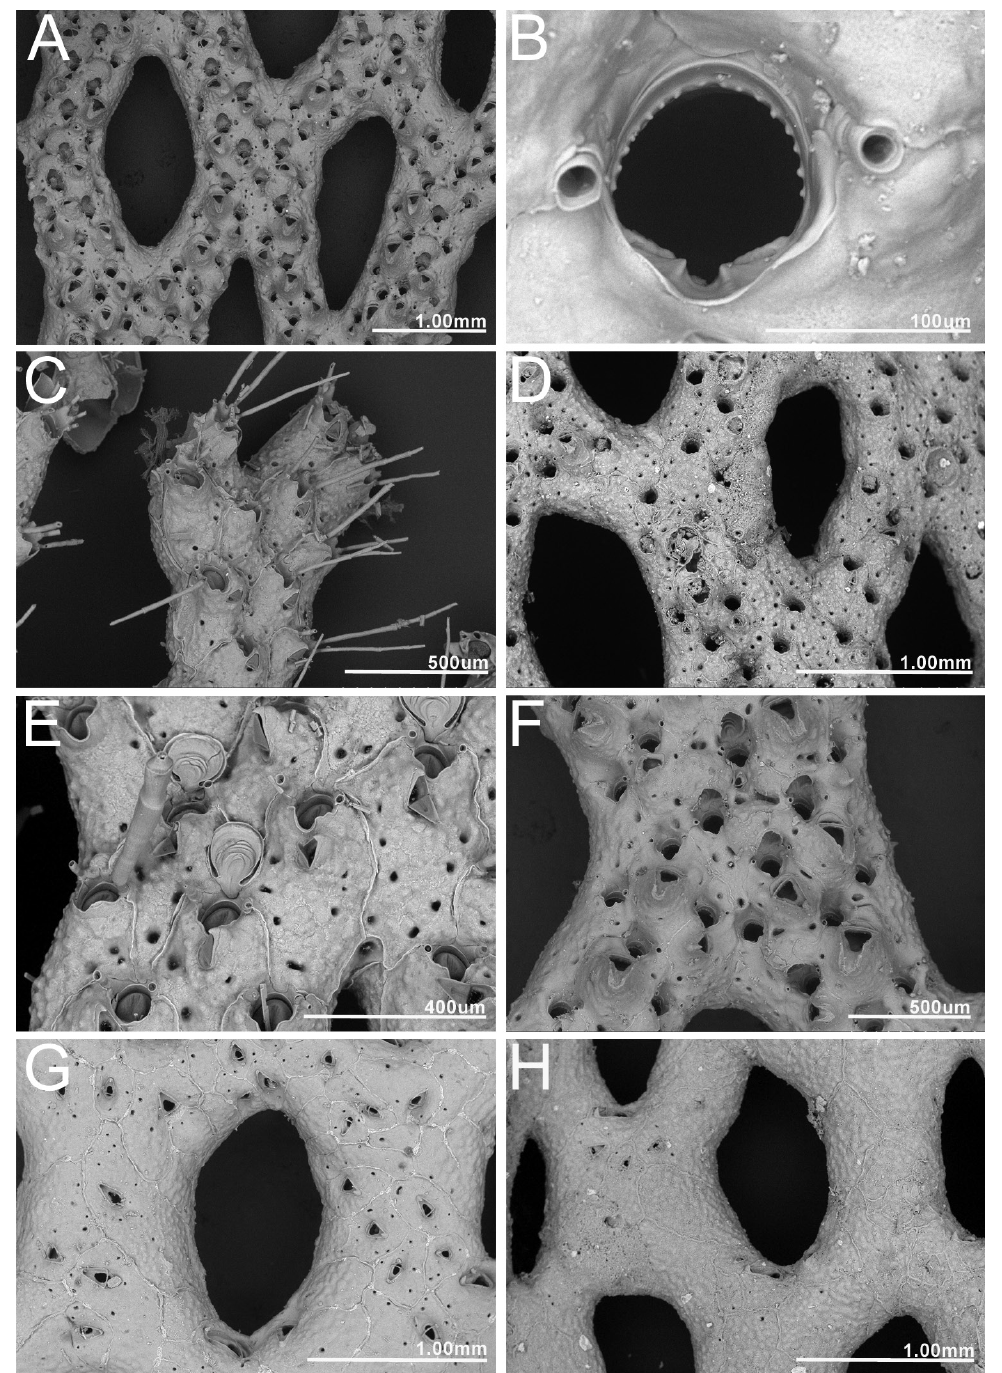
Fig. 7. Schizoretepora aviculifera (Canu & Bassler, 1930). A–B, F–G from Schizellozoon aviculiferum , holotype, coll. Canu (MNHN-IB-2014-24); C from specimen labelled as Schizellozoon longisetae (MNHN-IB-2008-11127); D, H from Schizellozoon granulosum , syntype, coll. Canu (MNHN- IB-2014-21); E from Schizellozoon aviculiferum (MNHN-IB-2008-11126). A . Frontal colony view. B . Primary orifice detail. C . Apical view of colony (note the articulated and carenated spines). D . Old ovicellate colony. E . Detail of young autozooids showing ovicells in formation and adventitiuos avicularia (note the giant club-like spine). F . Ovicellate zooids. G . Abfrontal view with avicularia. H . Abfrontal view showing triangular